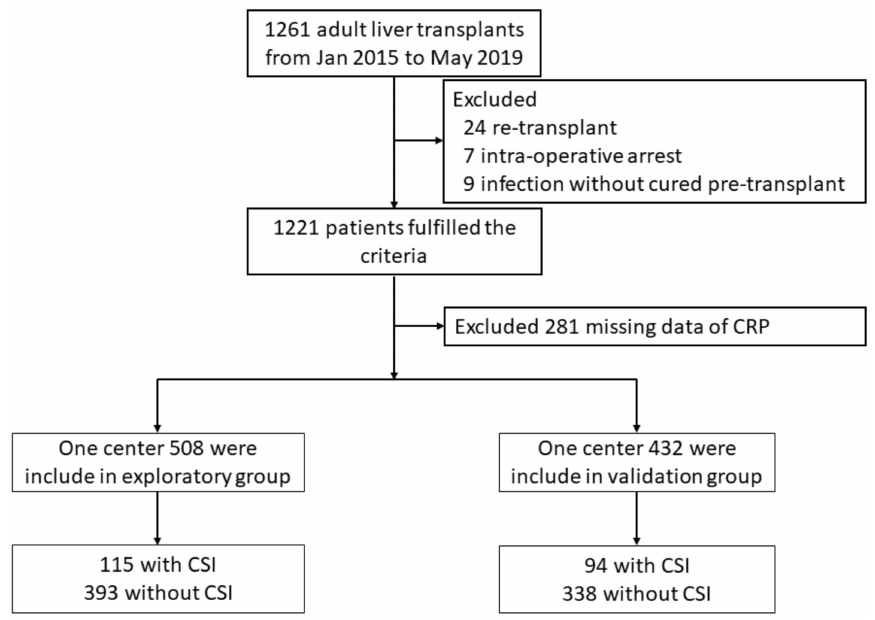
Figure 1. Flowchart of patient selection. CRP, C-reactive protein. Table 1. Baseline characteristics of the exploratory and validation